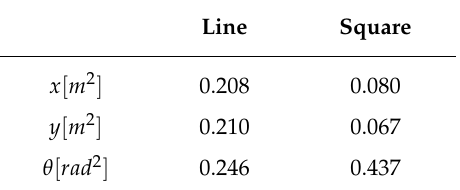
Table 3. Mean square errors (MSE) of Tracking Different Trajectories.